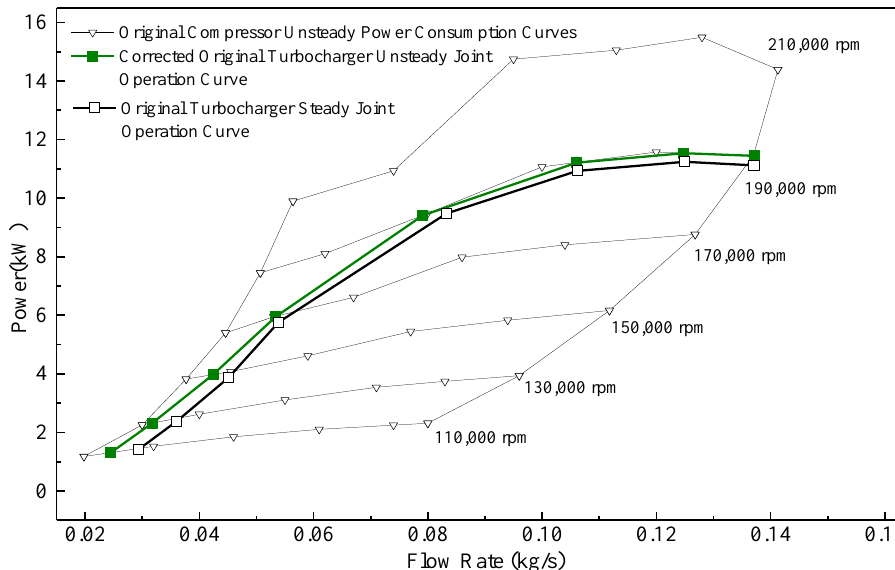
Figure 12. The original turbocharger corrected internal joint operation curves.